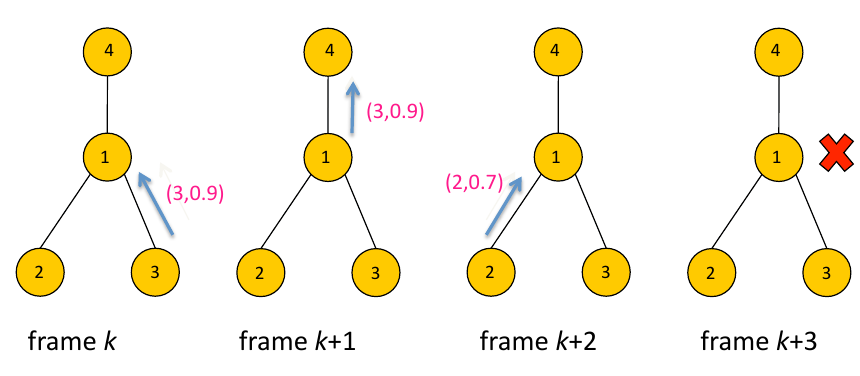
Figure 5. An example of selective